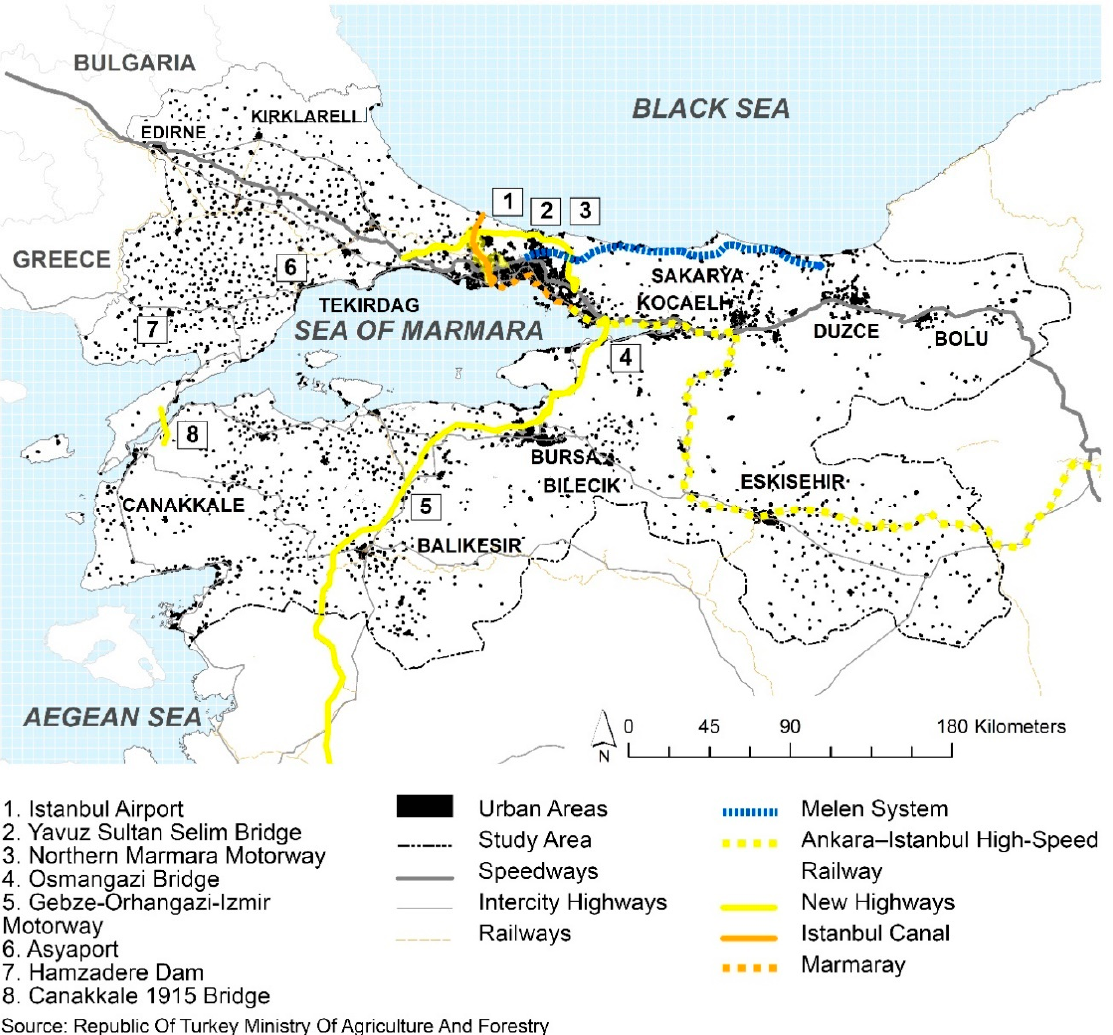
Figure 5. The study area of the Marmara Region and associated mega-projects.